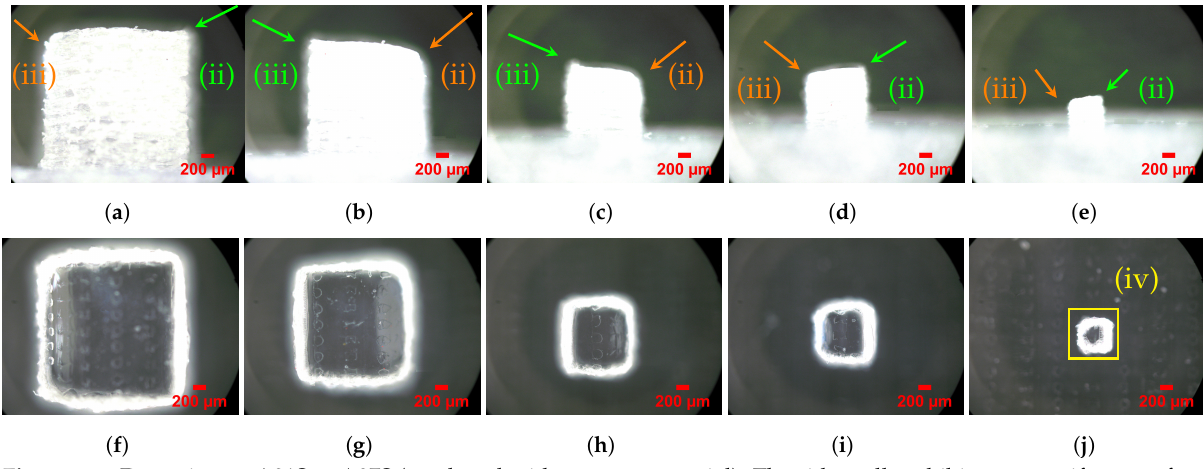
Figure 8. mD specimens A01S to A07S (produced with support material). The side walls exhibit a non-uniform surface finish (granulated satin). The top surface shows random geometrical deviations, similar to burr edges ( ii ) and rounded corners ( iii ), outside the ideal geometrical shape. ( iv ) For the size S07, the cube shows some geometrical distortion from a cube shape. ( a , f ) S01S side and top view; ( b , g ) S02S side and top view; ( c , h ) S04S side and top view; ( d , i ) S05S side and top view; ( e , j ) S07S side and top view. For details about the conditions of the images taken, see Section